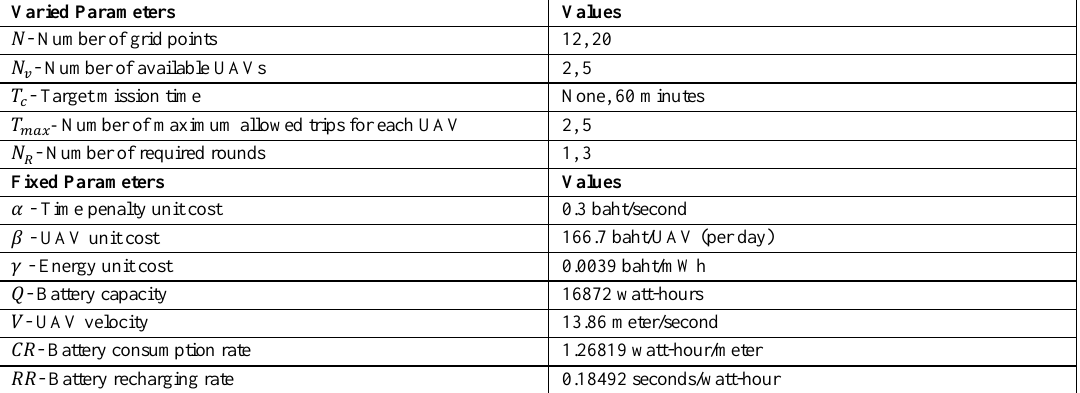
Table 4. Model parameters for two-level factorial